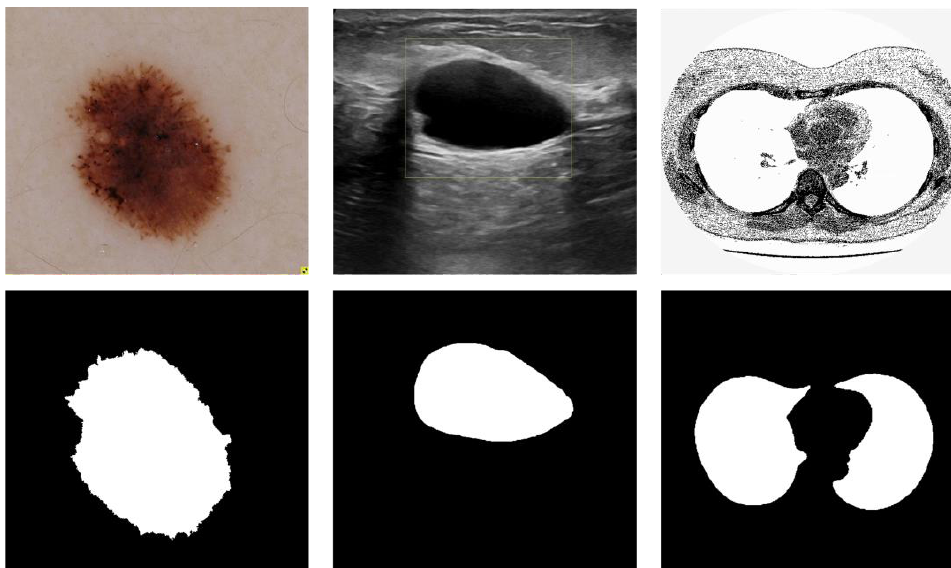
Figure 3. Medical image segmentation: skin cancer lesion segmentation on the left, breast cancer segmentation, and lung segmentation on the right.